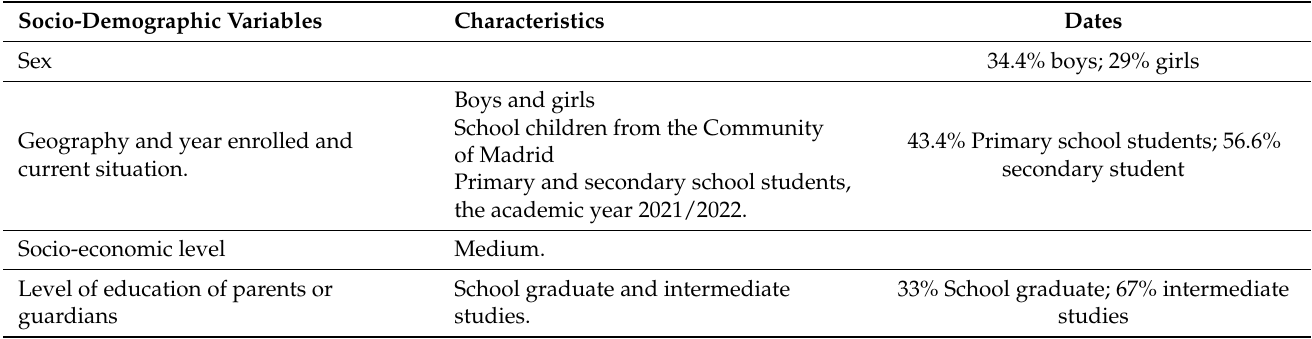
Table 1. Socio-demographic characteristics of